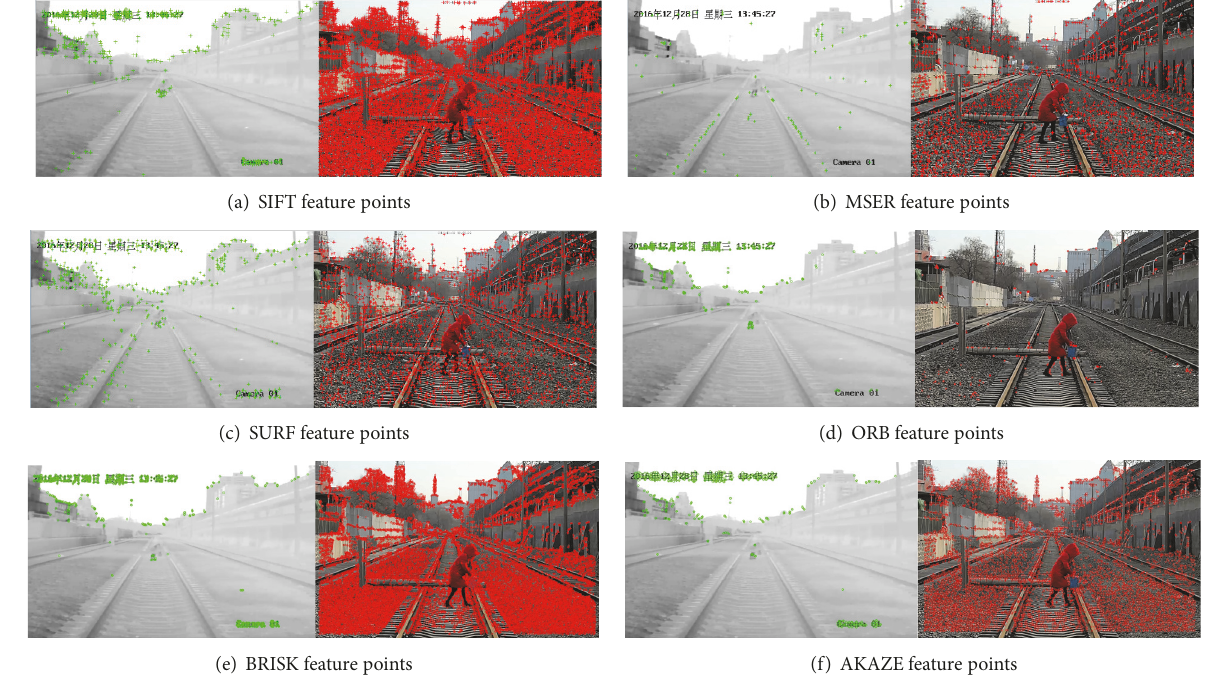
Figure 2: Comparison of different descriptors.